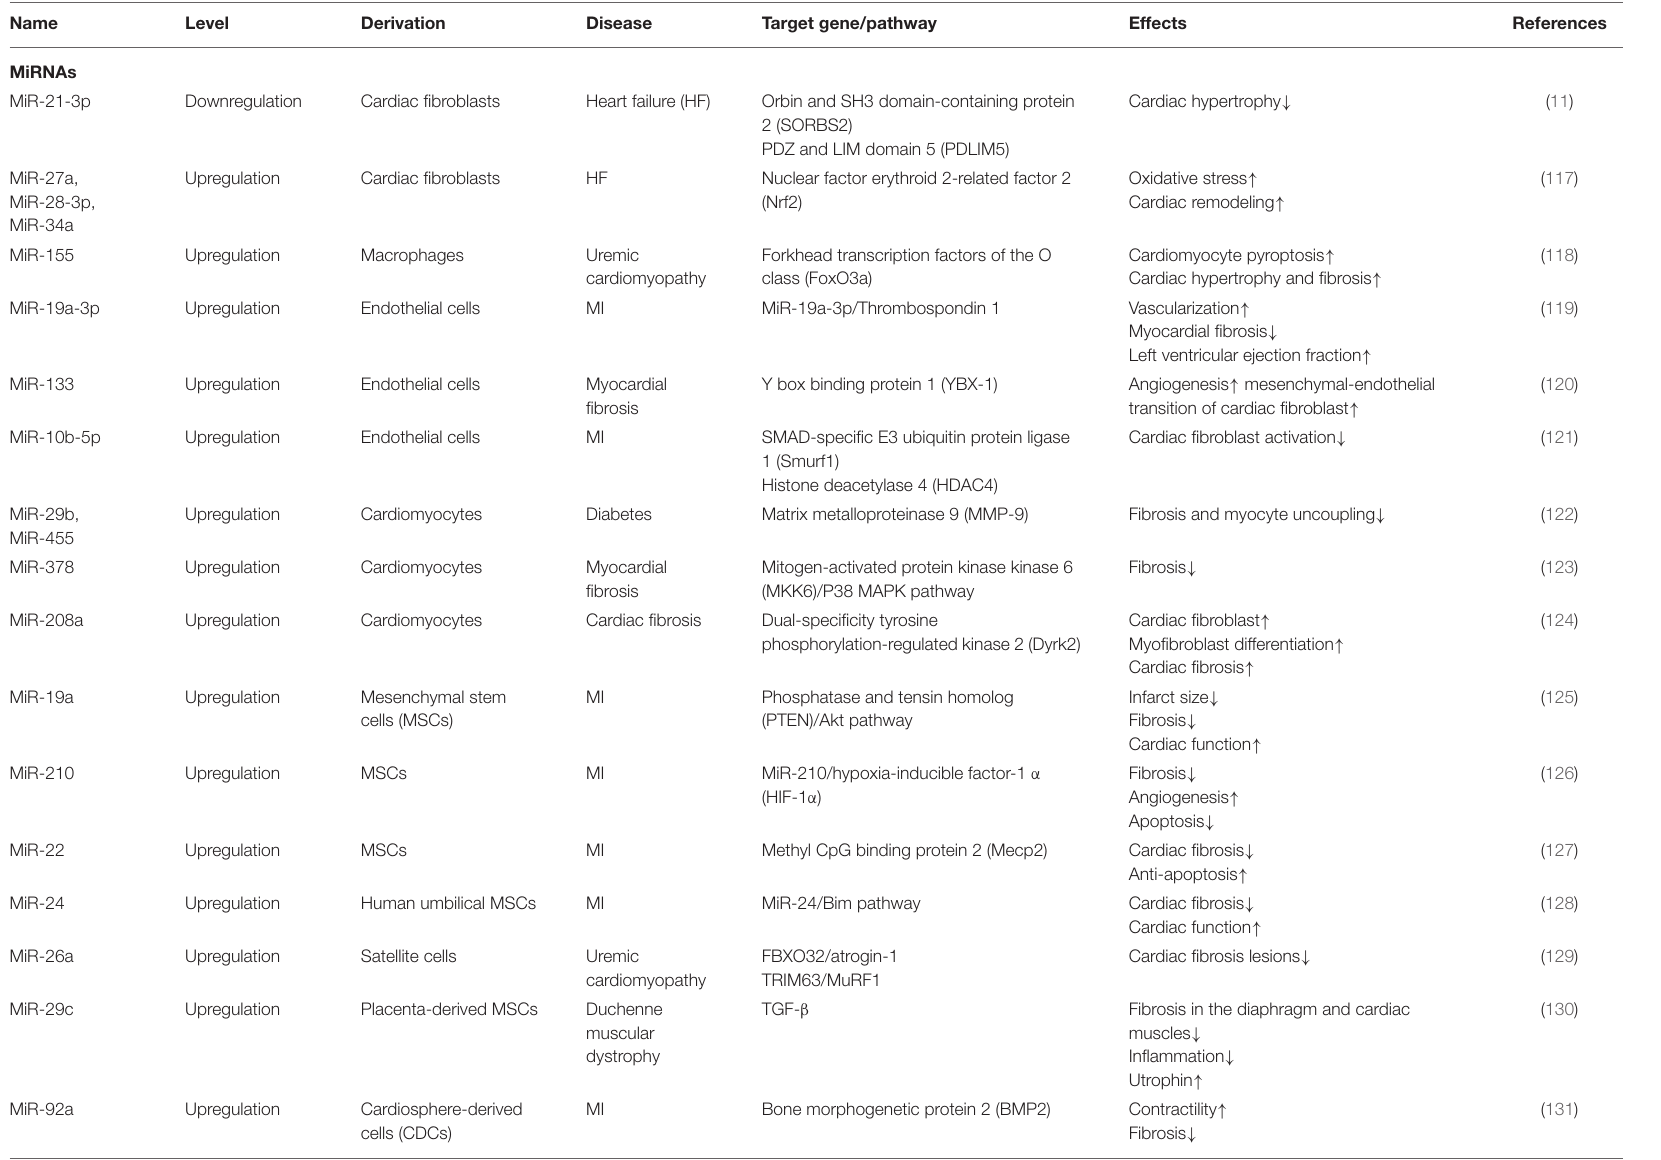
TABLE 2 | MiRNAs and proteins involved in exosomes for the treatment of cardiac